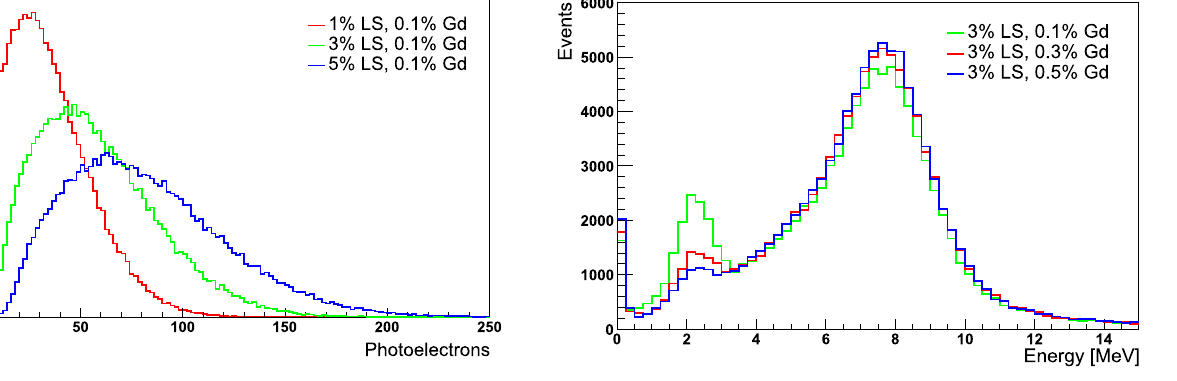
Fig. 6 Reconstructed delayed energy, E delayed , distributions for sev- eral WbLS cocktails with different mass fractions of Gd (0.1%, 0.3%, and